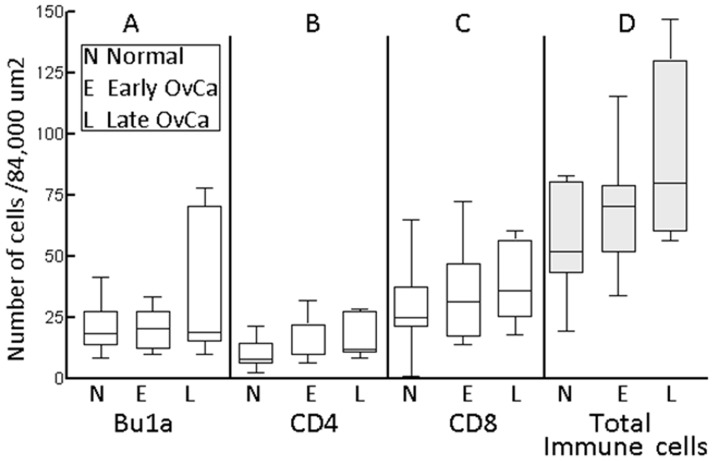
The number of Bu1a+ B cells and CD4+ and CD8+ T cells in normal ovaries and ovarian tumors determined by morphometric analysis.As shown in panels A-C for normal (N), early (E) and late stage (L) ovarian cancer, Bu1a+ cells and CD8+ T cells were more numerous overall than CD4+ T cells, particularly in late stage tumors. In panel D, the B and T cells counts were added. There was an overall increase in total (non-follicular) immune cells from normal ovary to late stage tumors. Cells were counted in multiple fields in three sections from each ovary for each hen at 20x magnification. The average number of B (Bu1a+) cells and CD4+ and CD8+ T cells was estimated from 11 hens with normal ovaries (number of fields counted was Bu1a = 524, CD4 = 425 and CD8 = 360), 8 hens with early stage ovarian cancer (number of fields counted was Bu1a = 228, CD4 = 190 and CD8 = 225) and 7 hens with late stage ovarian cancer (number of fields counted was Bu1a = 180, CD4 = 190 and CD8 = 200). Since the areas evaluated varied in size, all counts were normalized to 8×104 µm2.